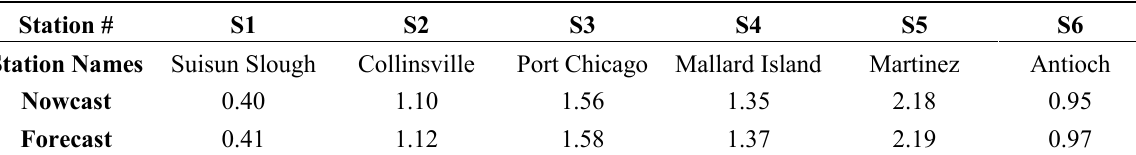
Table 16. Observed salinity standard deviations (PSU) at selected stations in nowcast and forecast